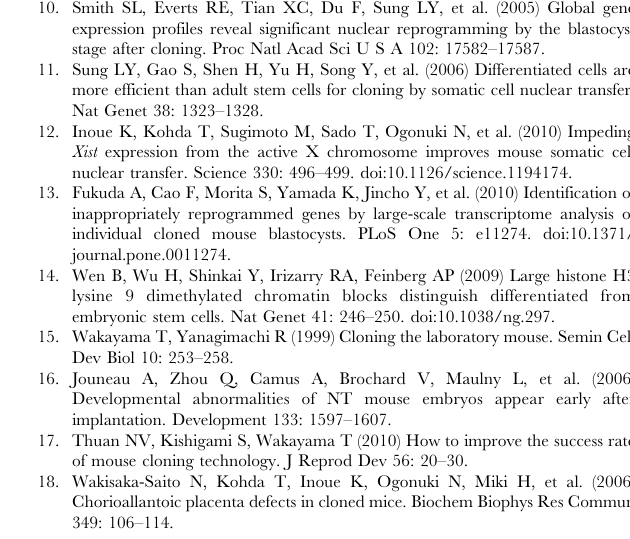
Figure S3: PCA of global gene expression profiles with an equivalent analysis of IVF-derived embryos (continued from Figure 2). As shown in Figure 2, gene expression similarities of embryonic samples (red, blue and green) are clearly distinguish- able according to the donor cell type, while clusters of extraembryonic samples (pink, light blue and light green) overlap each other. Red, blue and green represent the embryonic samples of cumulus cell-derived clone (CC), fibroblast-derived clone (FC) and neonatal Sertoli cell-derived clone (SC) samples, respectively. Pink, light blue and light green represent the extraembryonic samples of CC, FC and SC samples, respectively. Figure S4: Quantitative reverse transcription polymerase chain reaction (qPCR) for genes in the Dlk1–Dio3 imprint region. Gene expression levels between cumulus cell-derived clones (CC) and IVF-derived control samples were compared by qPCR. In a similar fashion to Figure 5, Dlk1 gene expression was upregulated in embryonic samples of CC ( P =0.018 by one-sided Student’s t test), though not in extraembryonic samples. There were no significant differences between the CC and IVF-derived control samples in the Gtl2 , Dio3 and Rian genes. Each dot represents the expression level relative to the Gapdh gene. Bars represent the means of samples in the same group. (PDF) Table S1 Primer list for qPCR. (XLSX) Table S2 Overlapping DEGs among the three SCNT